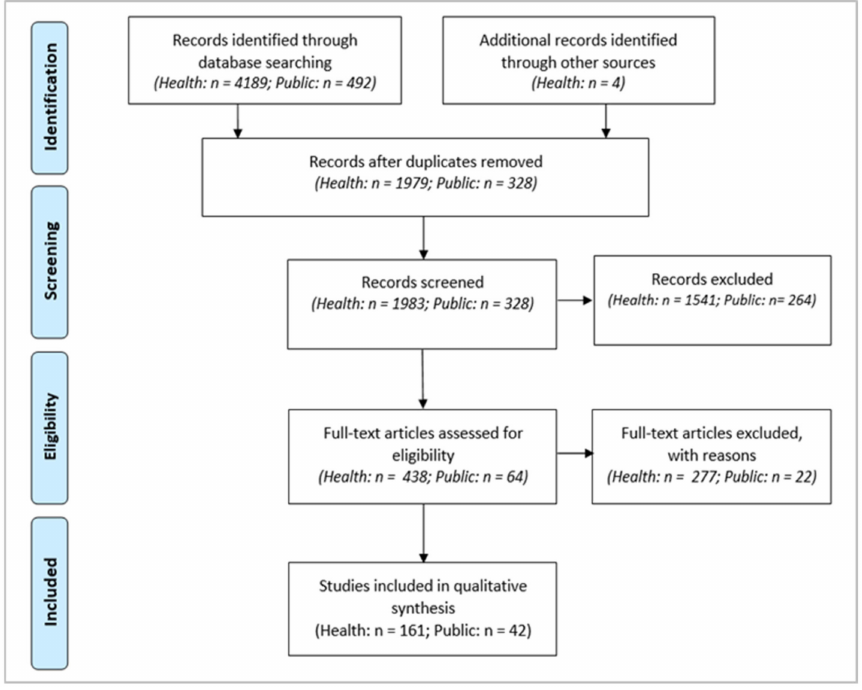
Figure 1. PRISMA